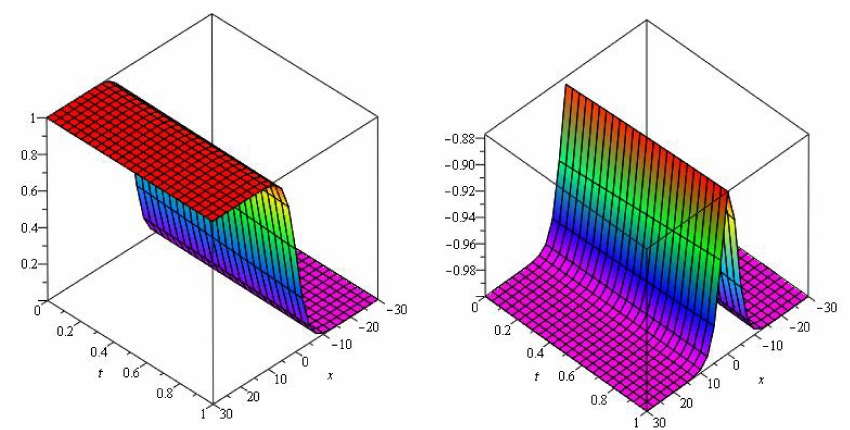
Figure 3. Graphs of µ ( ζ , τ ) and ν ( ζ , τ ) at ρ = 1 of example 2.